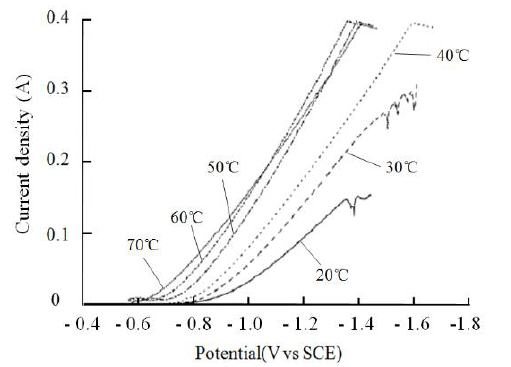
Figure 4. Nickel ion cathodic polarization curves in the plating solution at different temperatures.